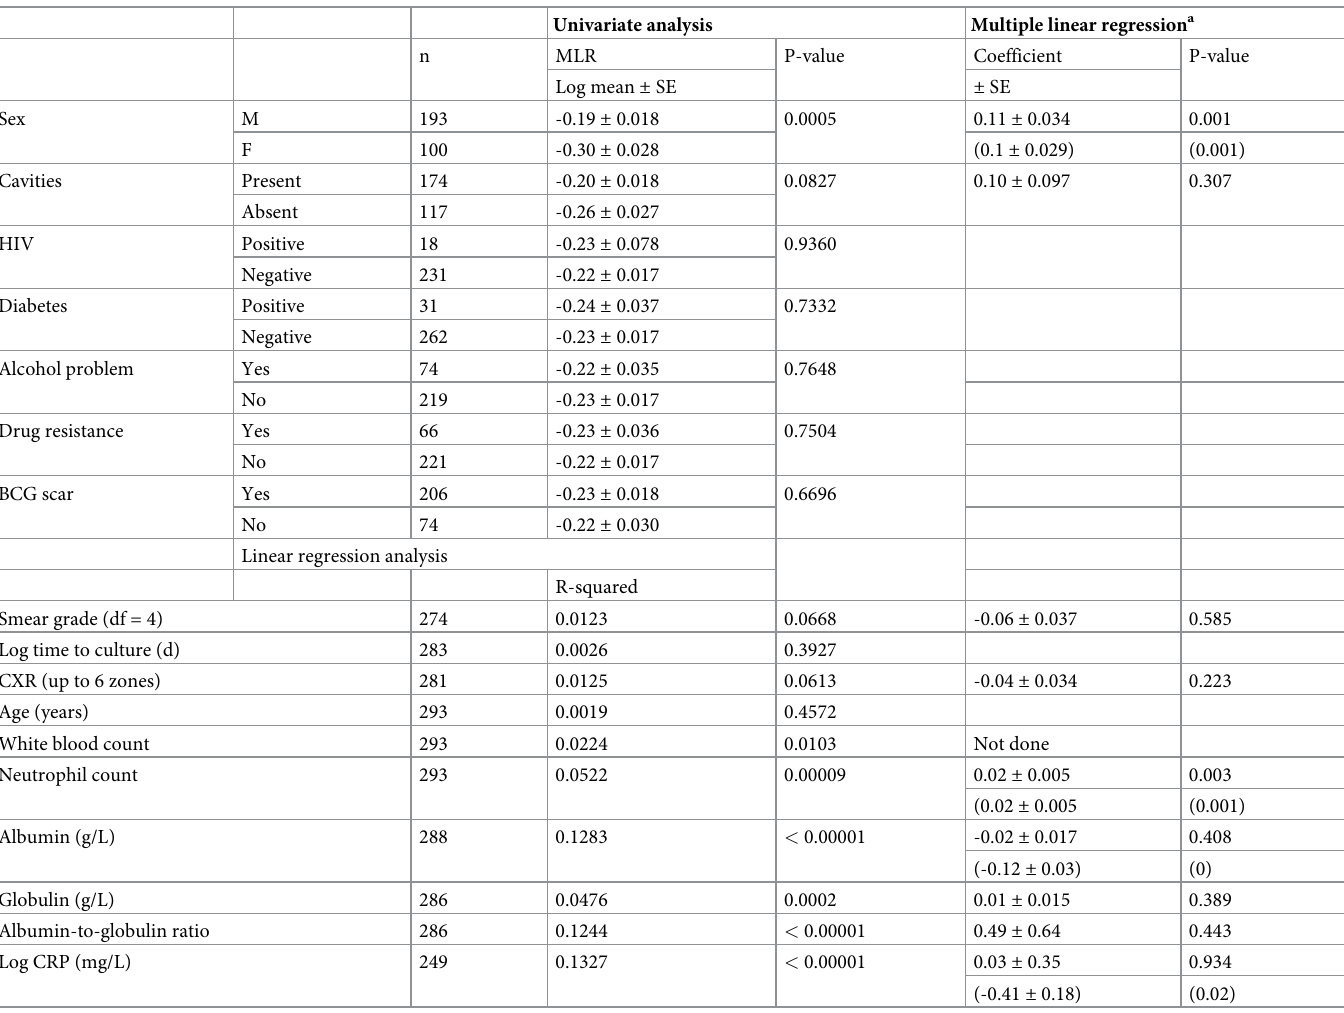
Table 3. Univariate and multivariable regression analysis of MLRs in